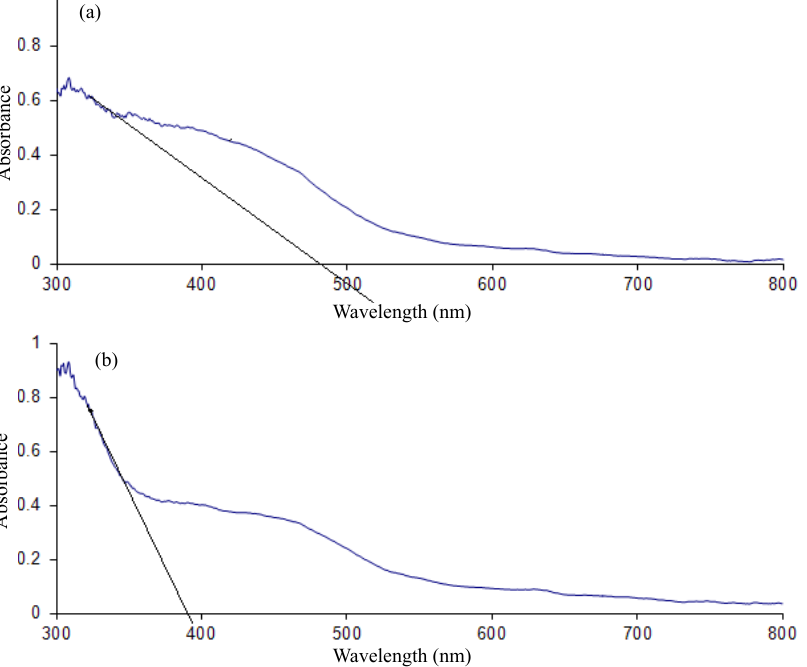
Fig. 7. UV–vis absorption spectra of prepared photocatalysts (a: CdS-TiO 2 -Tyrosine, b: CdS-TiO 2 )